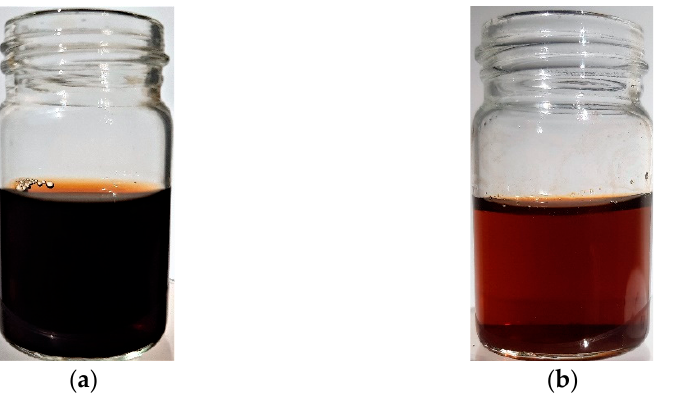
Figure 7. Hydrolysates obtained after 70 min of hydrothermal treatment of raw digestate ( a ) and washed digestate ( b ).